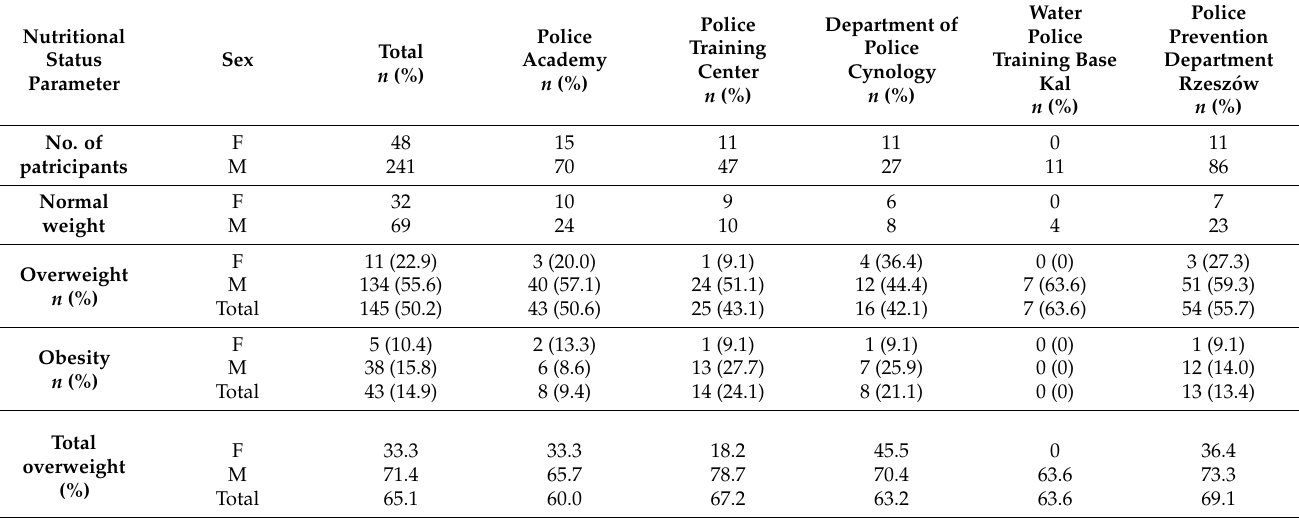
Table 3. The number of police officers with normal body weight, overweight, and